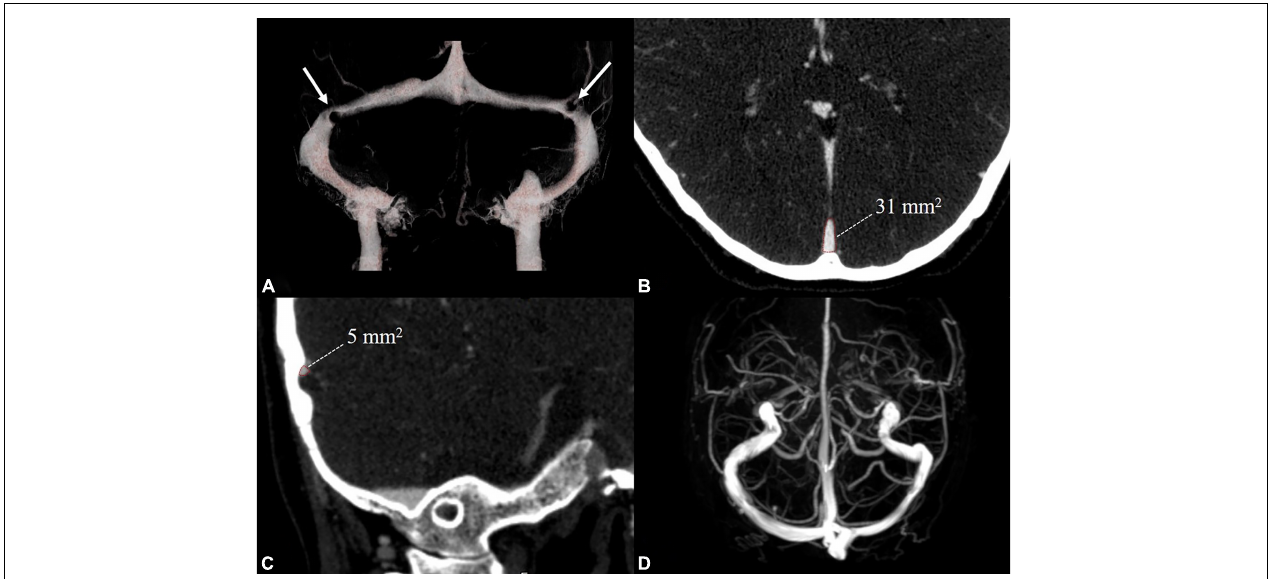
FIGURE 1 | Examples of radiological evaluation in a venous PT patient with TSS and a healthy control. CTV (A) showed bilateral TSS in the venous PT patient (white arrow). The cross-sectional area of the distal superior sagittal sinus (B) and TSS (C) were measured perpendicular to the venous sinus. MRV (D) showed no TSS in the healthy control. TSS: transverse sinus stenosis.